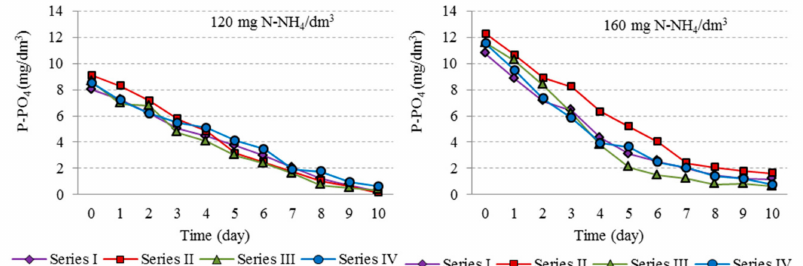
Figure 3. The changes of P-PO 4 concentration in the medium during cultivation of Chlorella vulgaris in the variants and series of